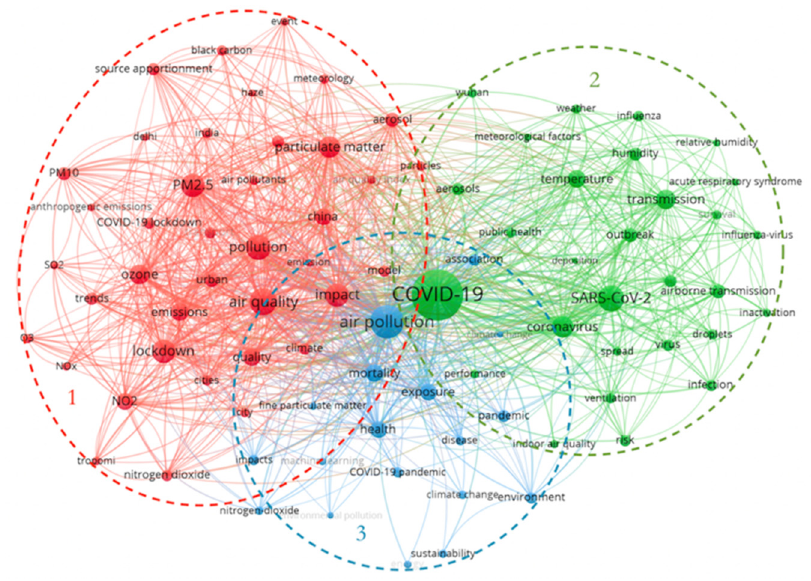
Figure 7. Keyword co-occurrence clustering.